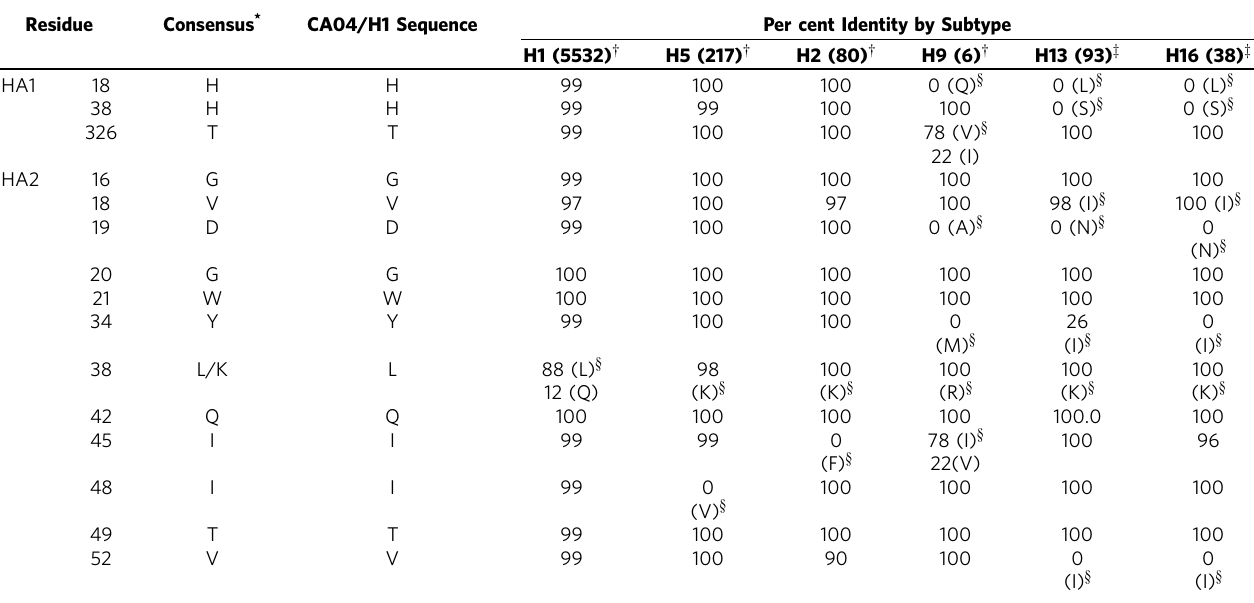
Table 2 | Sequence identity of 3E1 epitope by